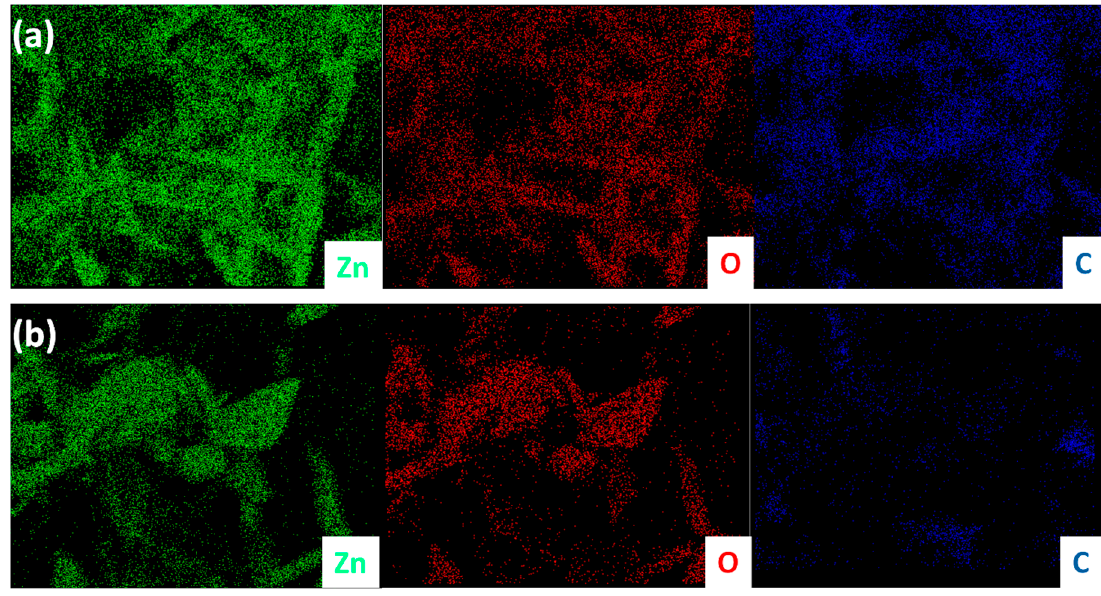
Figure 2. EDX mapping of ZnO TPs/chitosan ( a ) and ZnO TPs/Nafion ( b ). Green color represents zinc, red is oxygen, and dark blue is carbon.